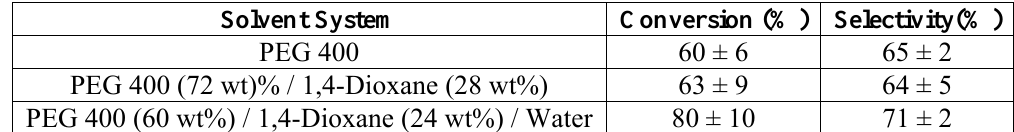
Table 6. Conversion of 1-bromo-3,5-dimethylbenzene and o -cresol with potassium hydroxide and selectivity of o -tolyl-3,5-xylyl ether in different solvent systems at 80 °C [15].